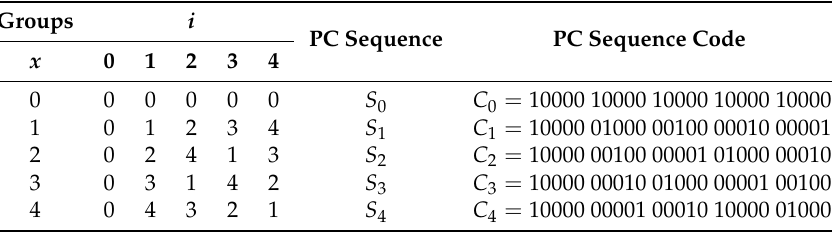
Table 6. Prime code (PC) sequences when p =